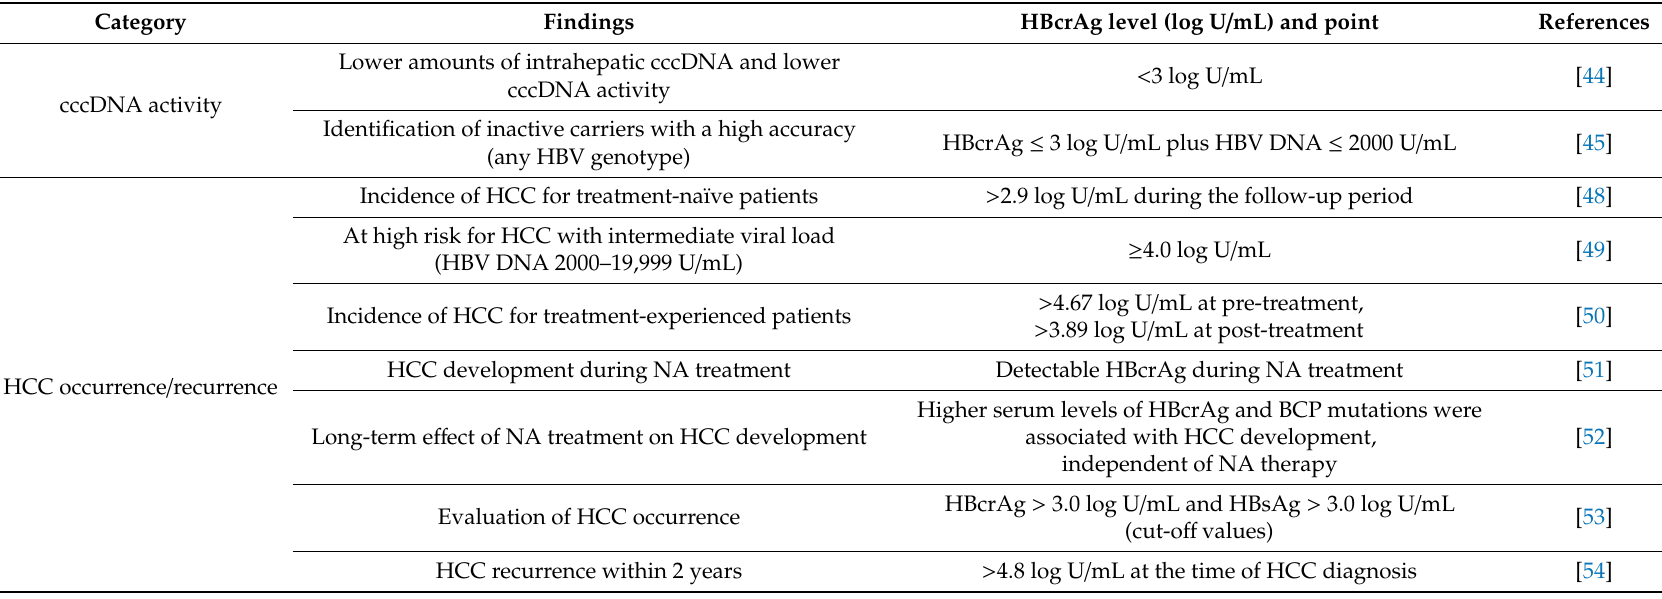
Table 1. Clinical applications of HBcrAg in CHB